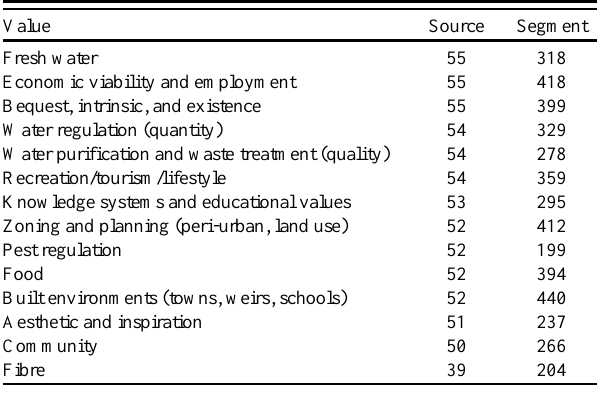
Table 3 . Frequency of codes ordered by frequency of